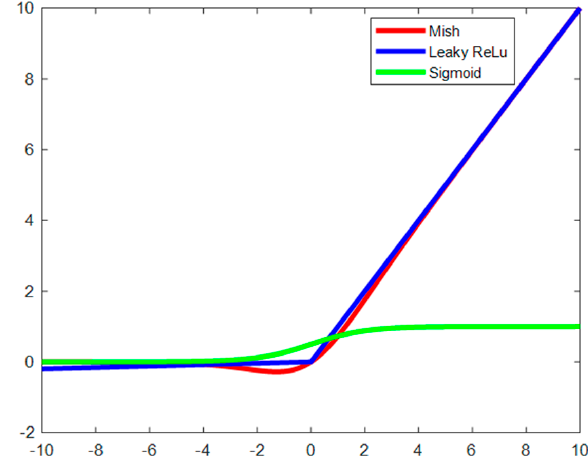
Figure 9. Comparison of Mish, Leaky ReLu, and Sigmoid function images.